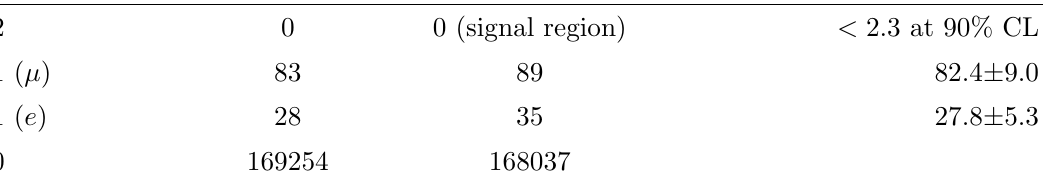
Table 6. Observed number of events in the control and validation regions used for evaluating the backgrounds in the displaced HNL signature, including all sources of background except for single cosmic-ray muons reconstructed as back-to-back muons and metastable particles. Transfer factors to translate the number of 0-lepton DVs to 2-lepton DVs are obtained using a same-charge DV control sample. Validation is performed using 1-lepton DVs. The number of events in the signal and validation regions is also